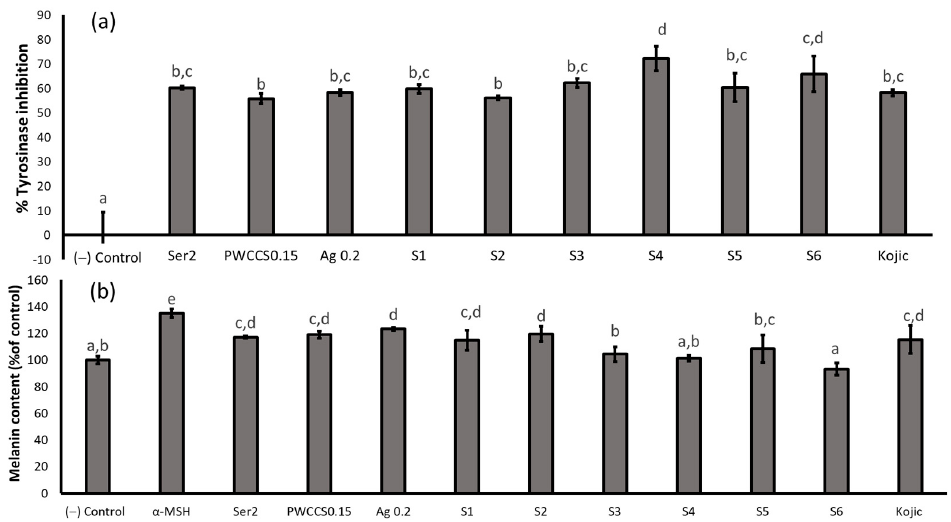
Figure 6. Effect of the α -melanocyte-stimulating hormone ( α -MSH), 2% sericin (Ser2), 0.15% PWCCS (PWCCS 0.15), 0.2% alginate (Ag0.2), 100 µ g/mL kojic acid (Kojic), and the hydrogels S1–S6 treatment for 48 h on the ( a ) tyrosinase activity (% inhibition) and ( b ) melanin content on the B16F10 melanoma cells. Data represent the mean ± SEM of the three replicates. Statistical significance was evaluated by Duncan’s post-hoc test; a–e letters indicate significant differences between the group at p < 0.05.